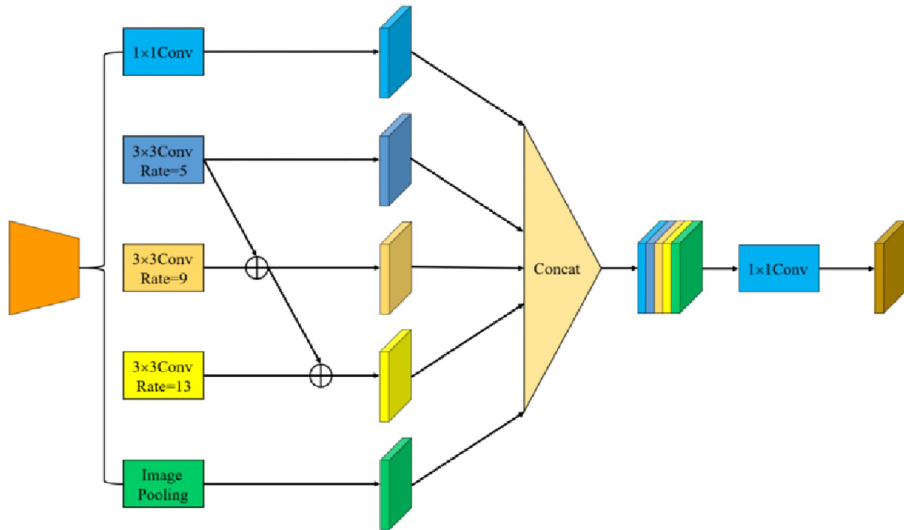
Fig 7. The structure of the CASPP